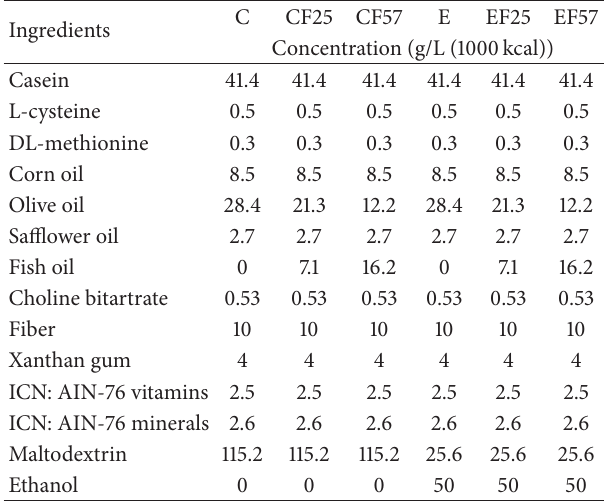
Table 1: Composition of the experimental liquid diets in each group 1,2